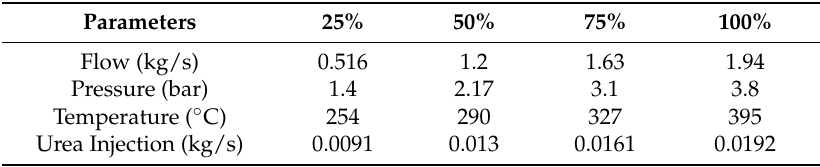
Table 1. Exhaust conditions of marine Diesel